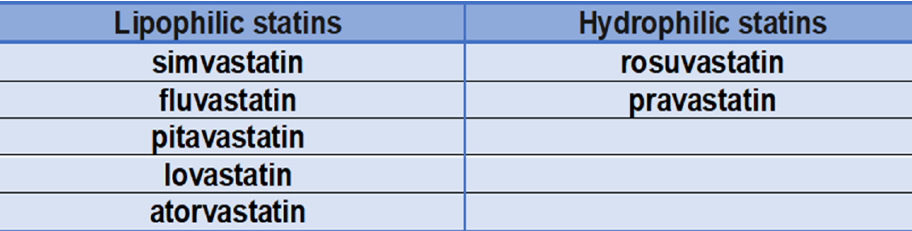
Figure 2. Hydrophilic and lipophilic statins.